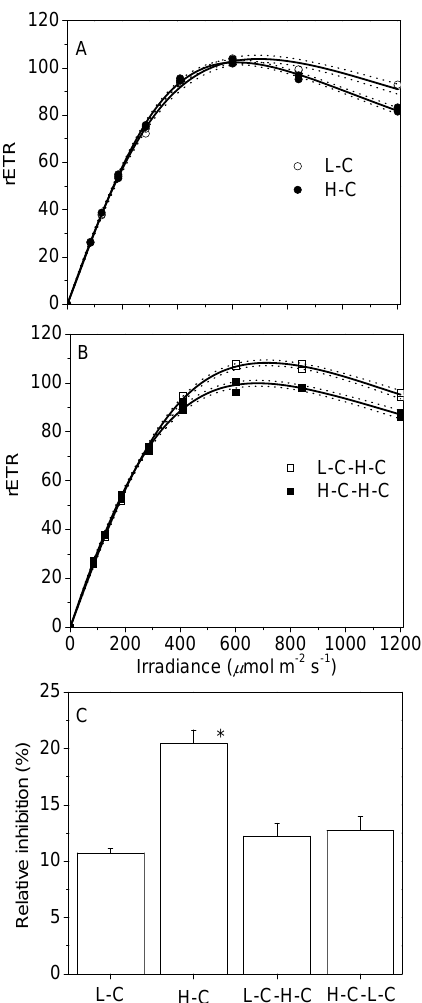
Fig. 4. The rapid light curve of low (L-C) and high CO 2 grown cells (H-C) measured under (A) CO 2 conditions as in their growth medium and (B) measured after transfer to high (L-C-H-C) and low CO 2 levels (H-C-L-C), respectively, and (C) the inhibitions rela- tive to P m caused by actinic light at 1200µmol m − 2 s − 1 . Solid lines represent the best fit of these points, while dotted lines rep- resent 95% confident bands, stars represent significant difference ( p < 0.001), vertical bars represent SD, n =4.